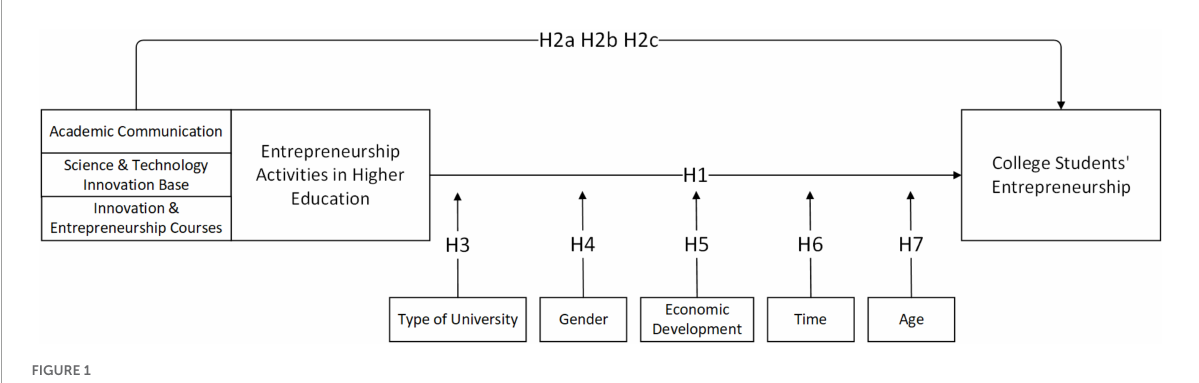
FIGURE1 The overall study hypothesis